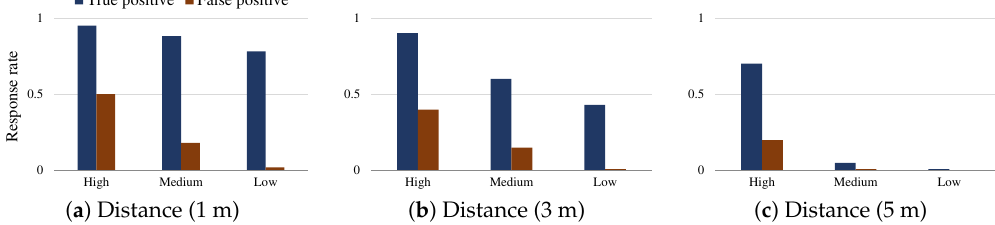
Figure 2. Tradeoff of Sensitivity Configuration for Hotword Response: ( a ) the response rates (on y -axis) depending on the sensitivity options (on x -axis) when a hotword is uttered at 1 m distance; and ( b , c ) the cases of 3 m and 5 m distance, respectively. The test was performed 100 times per each configuration (combination) of three sensitivity options, five testers (adults aged over 25, with about 70 dB utterance volume), and three different distances in a room (5 m 2 ) with no significant ambient noise, less than 40